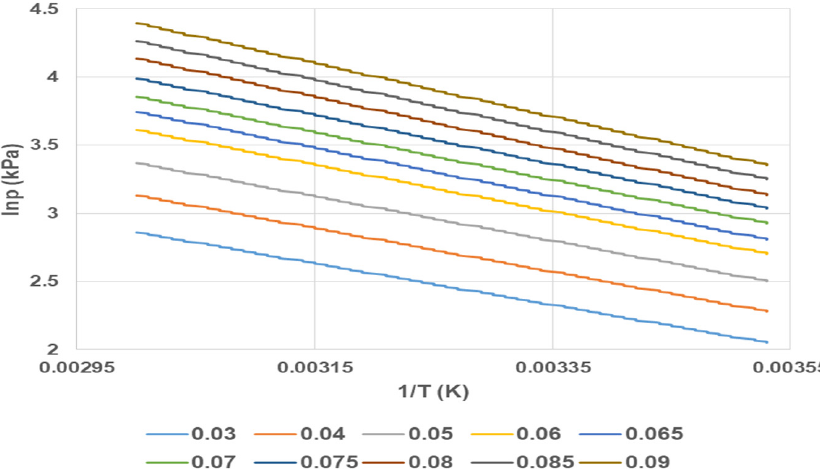
Figure 3. Isosteric lnp against 1/ T and the T represent the temperature from 283 K up to 333 K for 10 different uptake loadings.